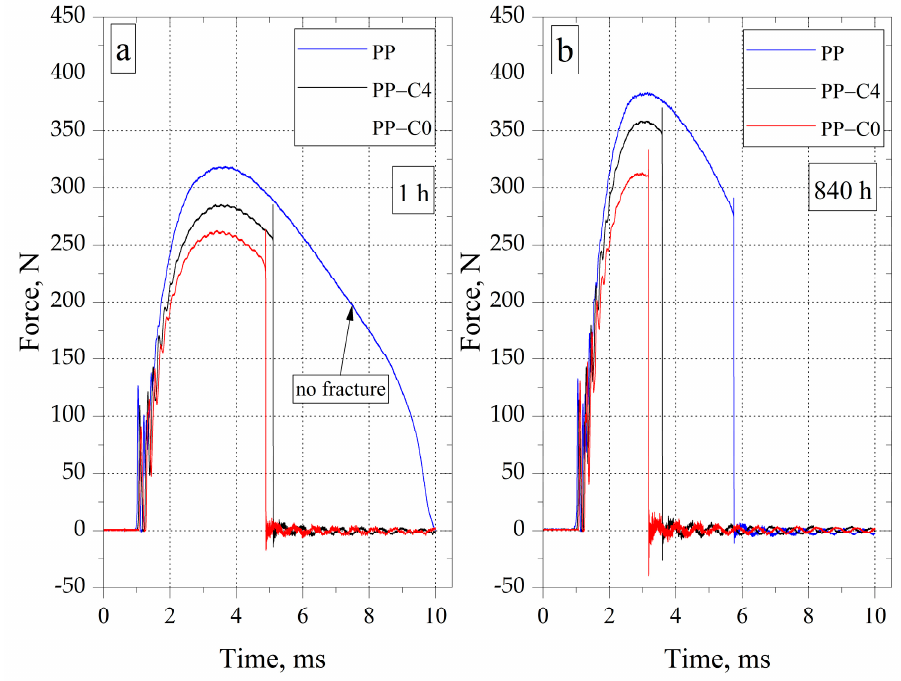
Figure 10. Dependence of the force on the time of fracture for the tested samples during the conditioning time equal to: ( a ) 1 h ( b ) 840 h.